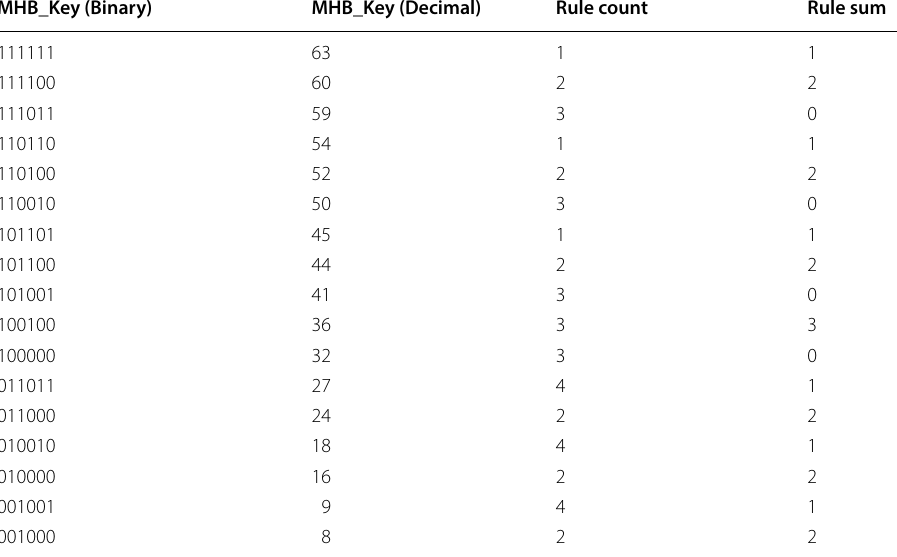
Table 7 Rule sum and count recalculation